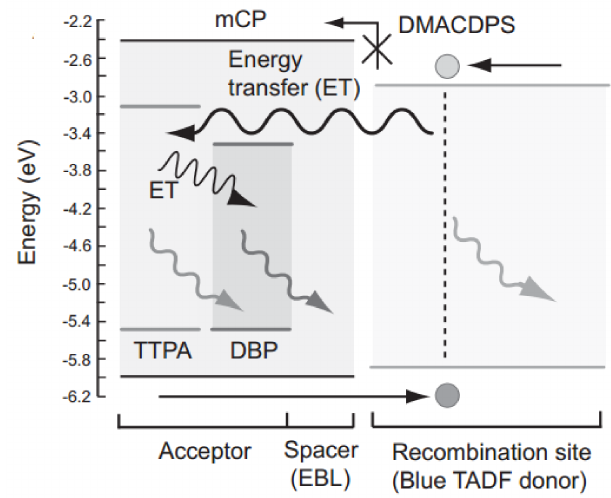
Figure 4. Schematic illustrations of a conceptual energy transfer mechanism from DMACDPS (common blue TADF emitter) to TTPA and DBP under electrical excitation. Reproduced with permission from [126], John Wiley and Sons,